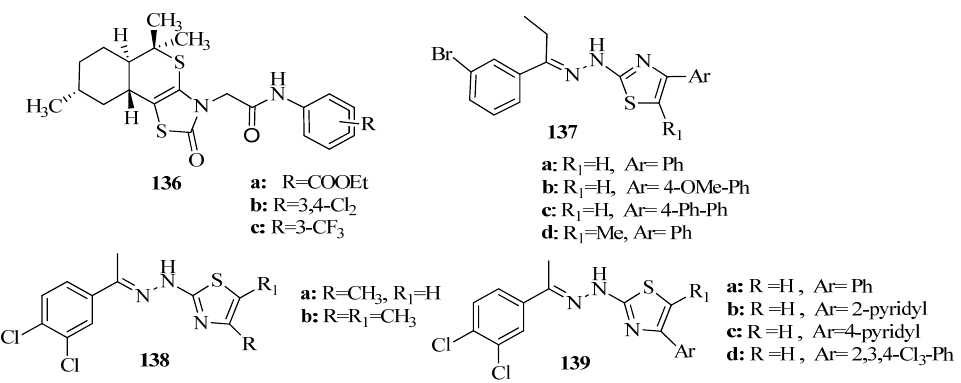
Figure 55. Structures of isothiochromeno[4a,4-d][1,3]thiazole derivatives ( 136 ), thiazolyl hydra-